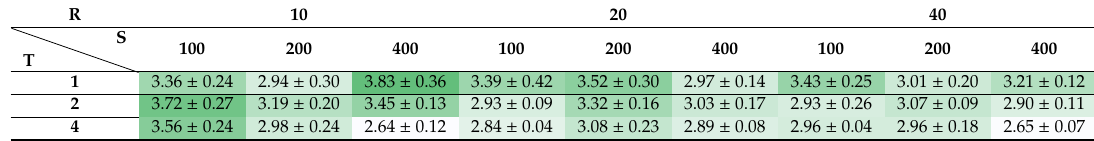
Table 1. Mean germination time (MGT) comparison of seeds washed at three stirring speeds, S (100, 200, and 400 rpm) for three durations, T (1, 2, and 4 h) in di ff erent amounts of water, R (10, 20, and 40 mL) per gram of